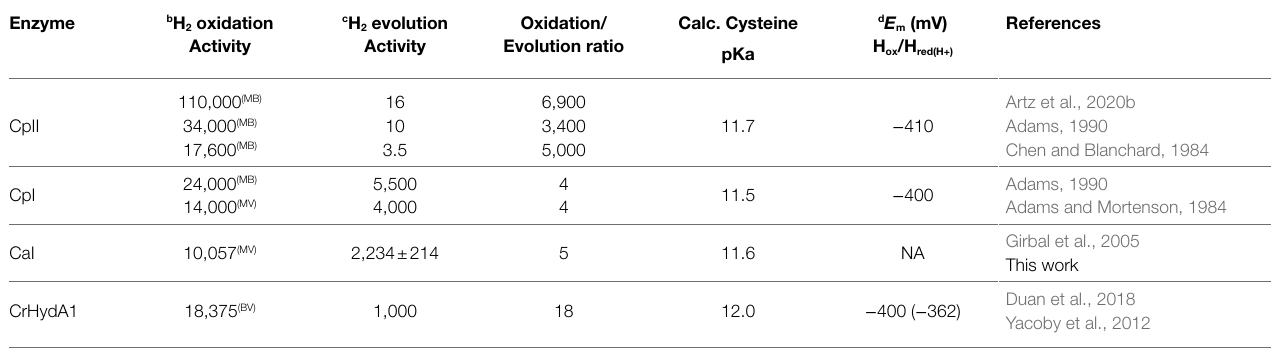
TABLE 1 | Overview of WT [FeFe]-hydrogenase activity a profiles.